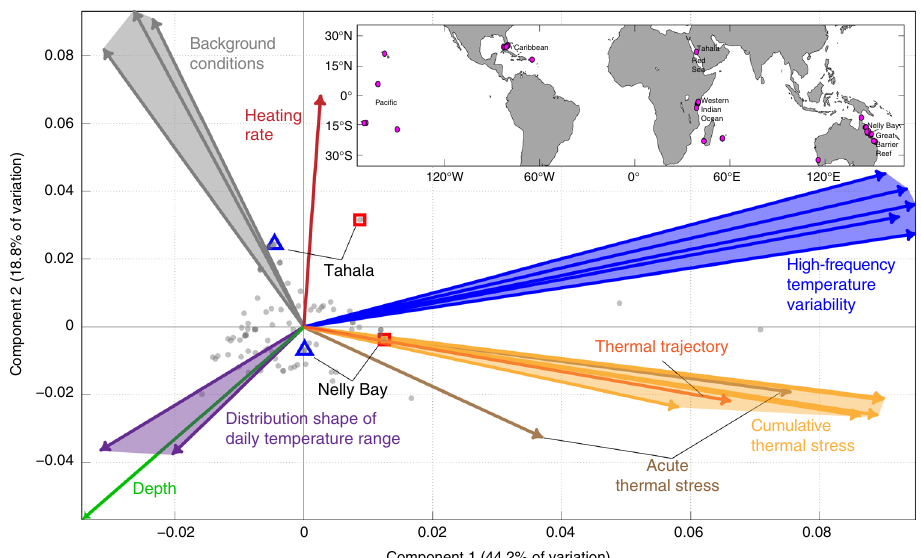
Fig. 1 First two axes of variation of site-speci fi c explanatory variables. Biplot of principal components analysis (PCA) showing the fi rst two components (44.2% and 18.8%, respectively) that explain the majority of the variance in the matrix of 20 in situ explanatory variables (Table 1) used to explain bleaching prevalence. The light gray dots ( “ scores ” ) each represent temperature time series associated with a distinct bleaching event at a given reef site. Gray dots that are close to each other have more similar temperature environments than dots further apart. The vectors are colored according to the categories described in Table 1. The time series inspected later in Fig. 4 are also indicated by red squares (Tahala and Nelly Bay shoreward habitats) and blue triangles (Tahala and Nelly Bay seaward habitats). The magenta circles in the inset map indicate the locations of all 118 in situ time series, with their associated reef regions labeled. The map was created using the MATLAB package “ M_Map ” , created by Rich Pawlowicz under the license Copyright (c) 2014, Chad Greene. All rights